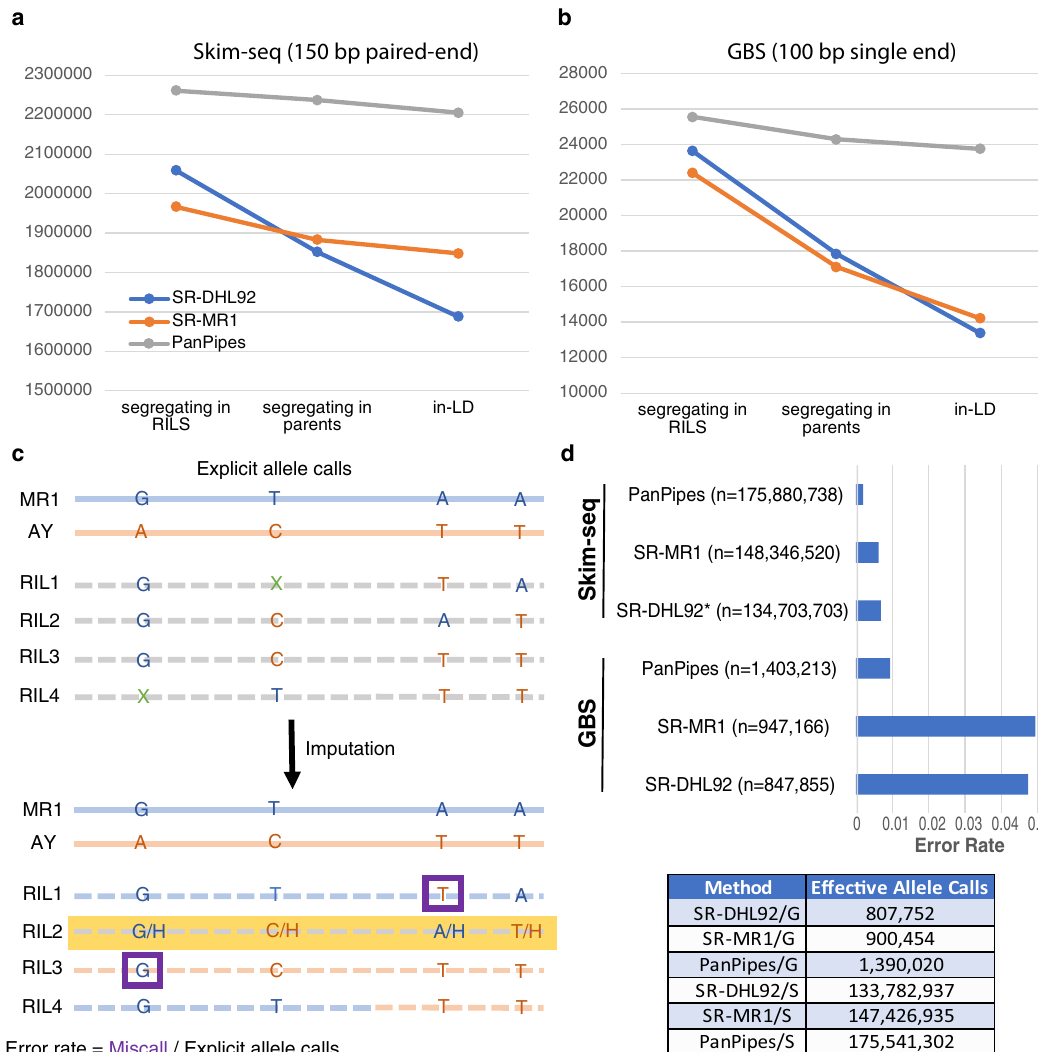
in a toy example. Green Xs indicate missing calls. Purple boxes indicate post- imputation assessment of miscalled alleles. Yellow highlighting indicates a likely contaminanthaplotypenotfoundineitherparent. d Boxplotsdepictrelativeerror rates. Adjacent tableshows grand totalsfor effective allele callsacross chemistries andmethods,whereGGBS,SSkim-seq. n valuesaretotalexplicitallelecalls(see c ). Source data are provided as a Source Data fi